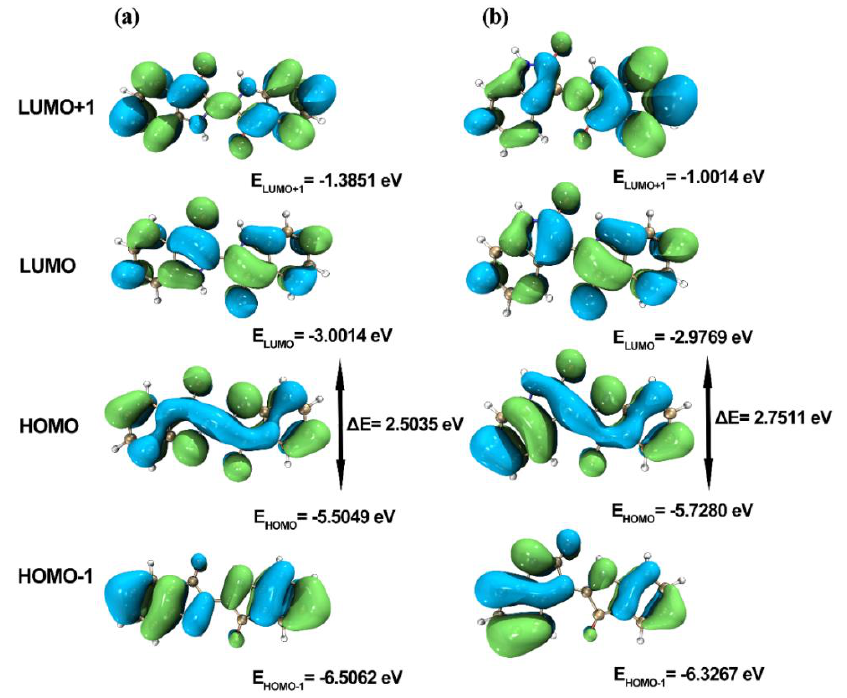
Figure 4. Frontier molecular orbitals of indigo ( a ) and indirubin ( b ). Table 2. Total molecular energy and frontier orbital energy.